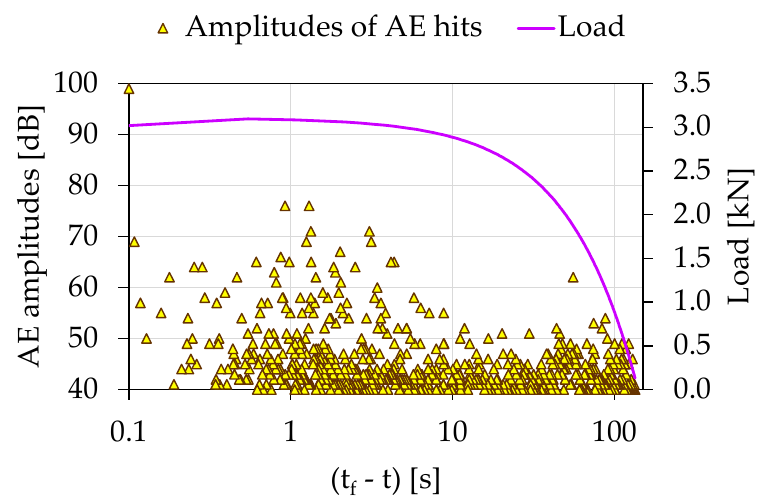
Figure 7. The temporal evolution of AE amplitudes in juxtaposition to the load applied for the experiment Exp-LR2 in terms of the “time-to-failure” parameter.